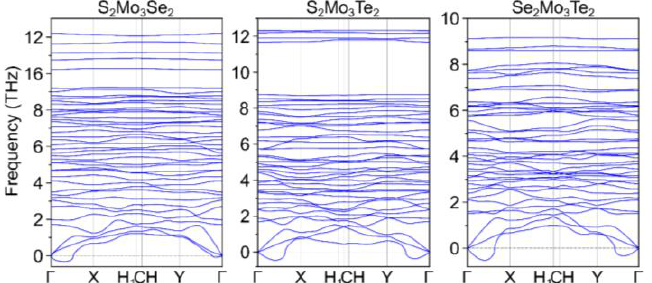
Figure 2. Phonon dispersion spectra for Ch 1 2 Mo 3 Ch 2 2 (Ch 1 /Ch 2 = O, S, Se, Te) Chevrel phases.